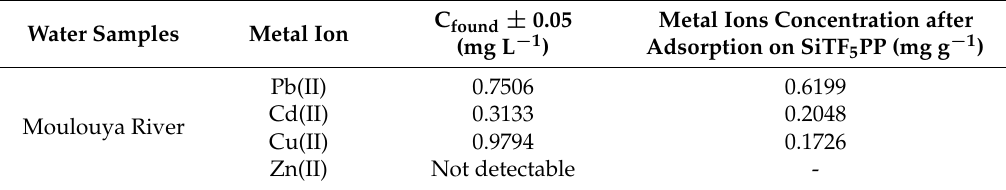
Table 6. Extraction of potential toxic metal cations in natural real water samples.